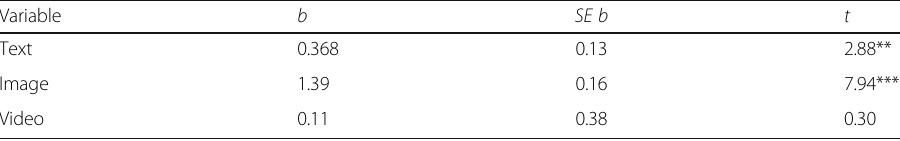
Table 4 Regression of number of interactions to posts ’ mode of interaction Variable b SE b t Text 0.368 0.13 2.88** Image 1.39 0.16 7.94*** Video 0.11 0.38